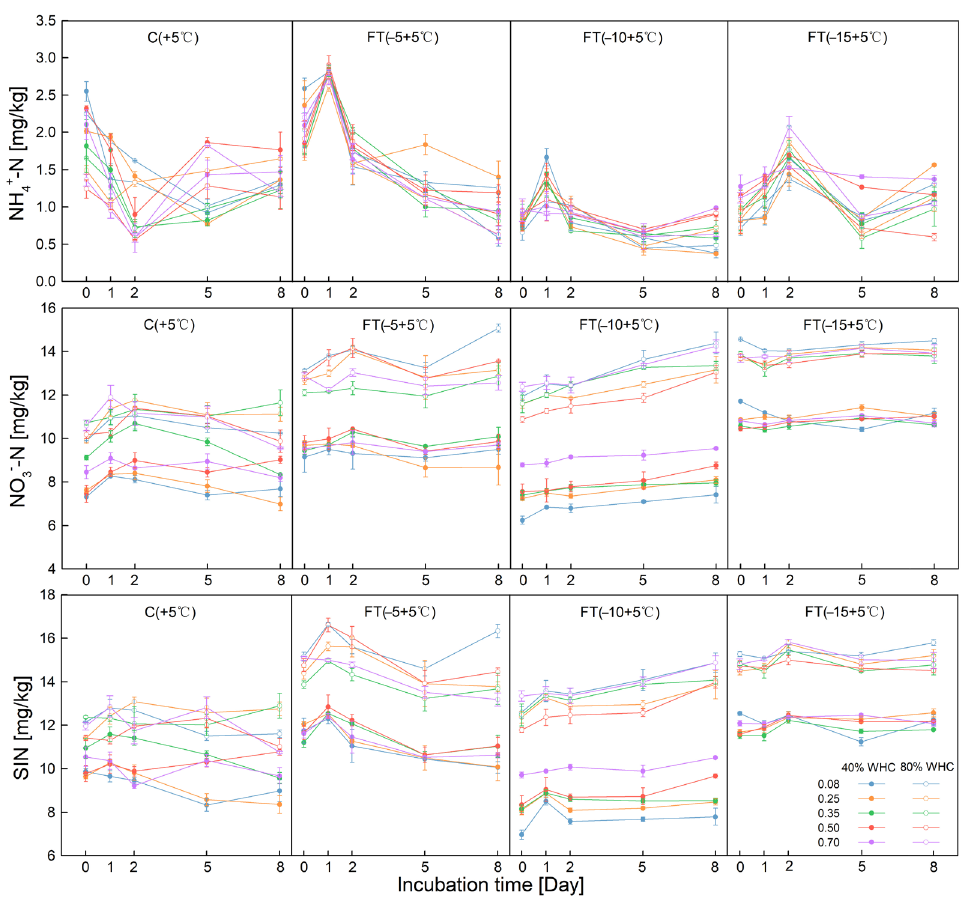
Figure 2. Soil NH 4+ -N, NO 3 − -N, and soil inorganic nitrogen (SIN) changes during the incubation period under different salinity, freezing–thawing (FT) temperatures/cycles, and soil moisture contents. Table 3. Results of multi-way analysis of variance (ANOVA) on soil mineral N variation under